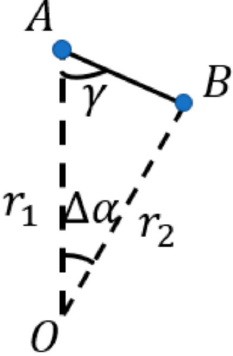
Figure 3. Angle γ , where A, B, r 1 and r 2 represent the end point, the adjacent point and their range, respectively. O represents lidar; ∆ α represents horizontal angle resolution of